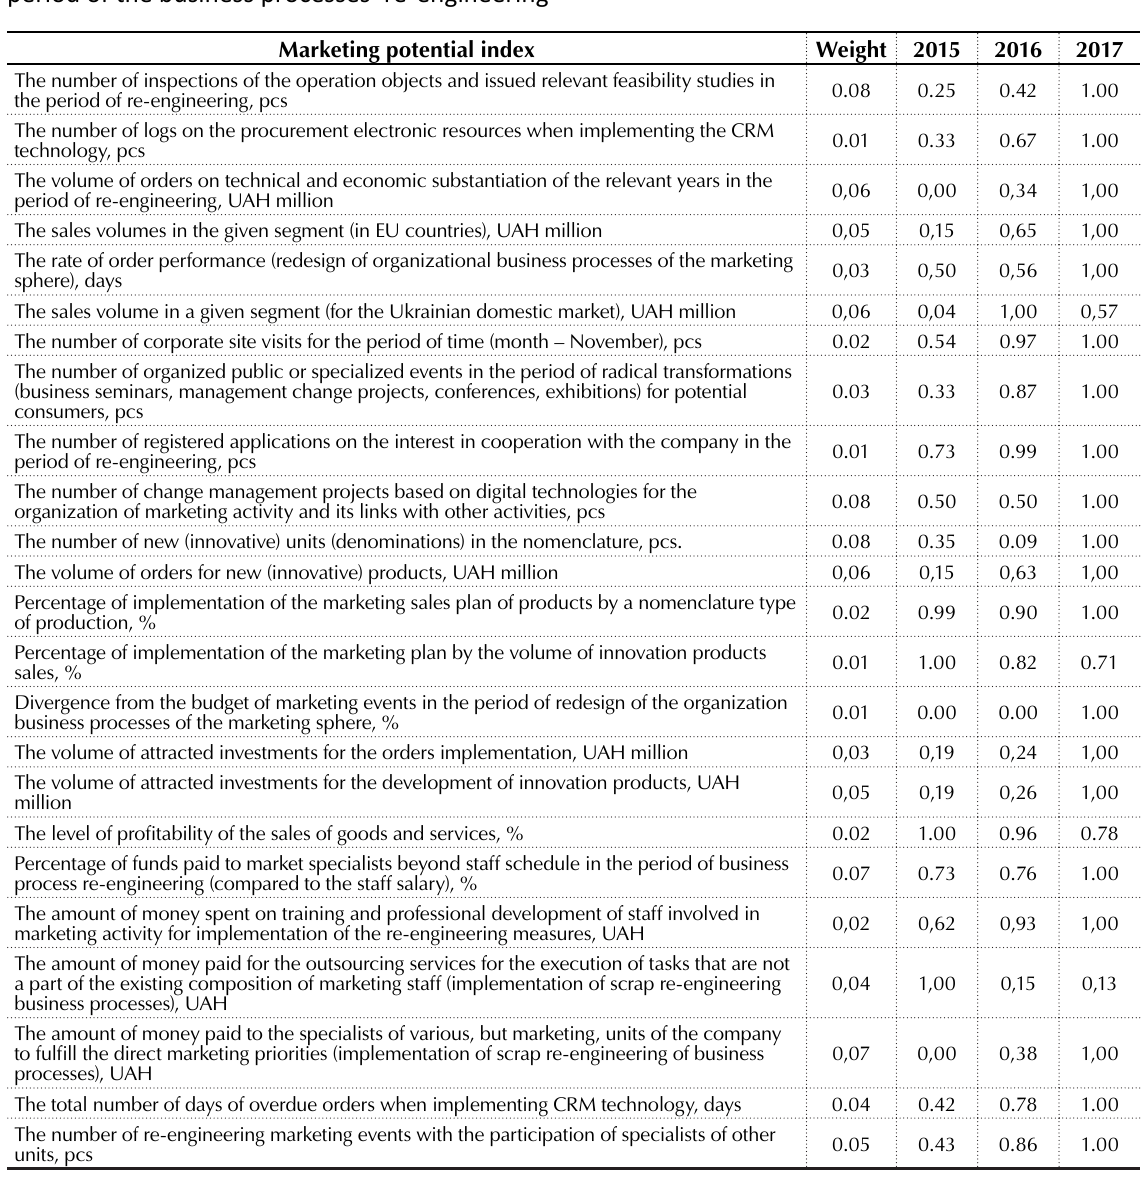
Table 3. Normalized indices of the marketing potential of JSC Sumy Plant Nasosenergomash in the period of the business processes’